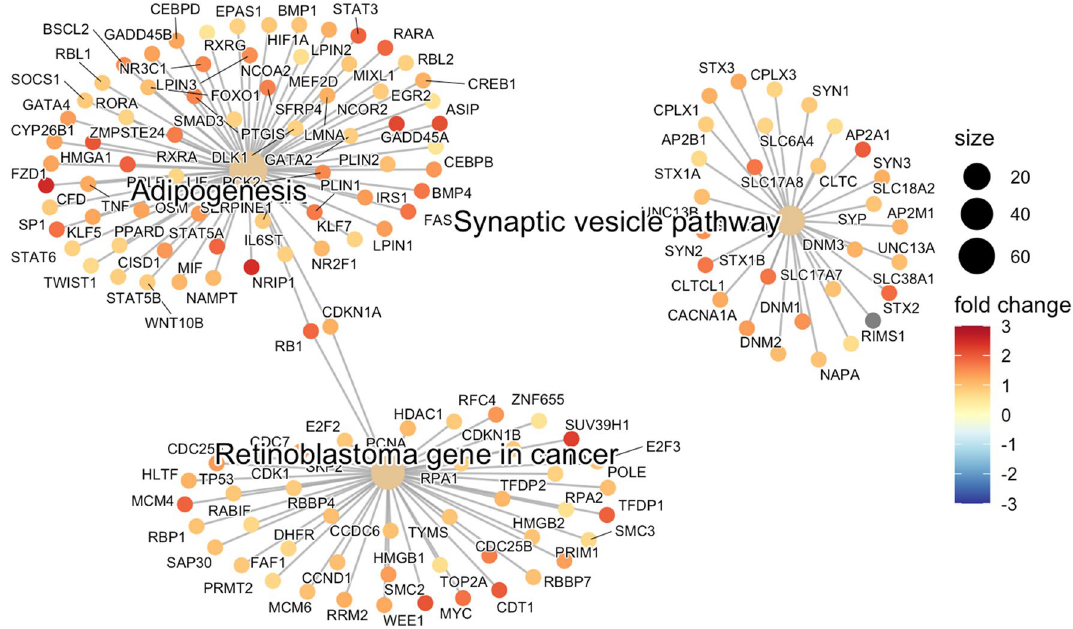
Figure 1. Visual representation of top 3 significantly altered pathways and their constituent genes identified in ovarian cancer circulating cfDNA. Data set has been utilized Features (CpG sites) selected by RFE #